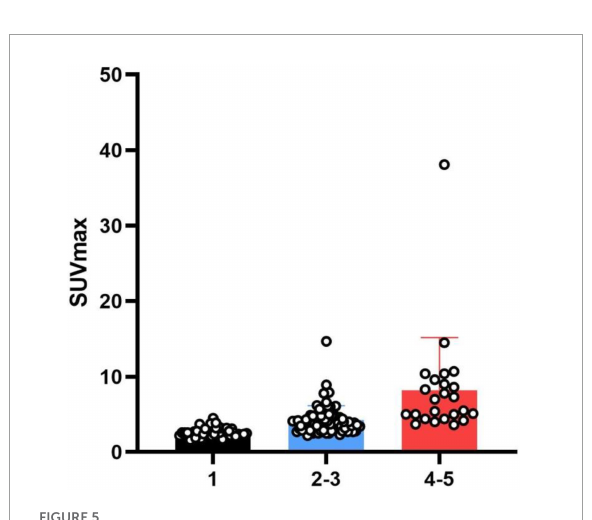
FIGURE5 Comparison of standardized uptake values (SUV max ) among different groups.